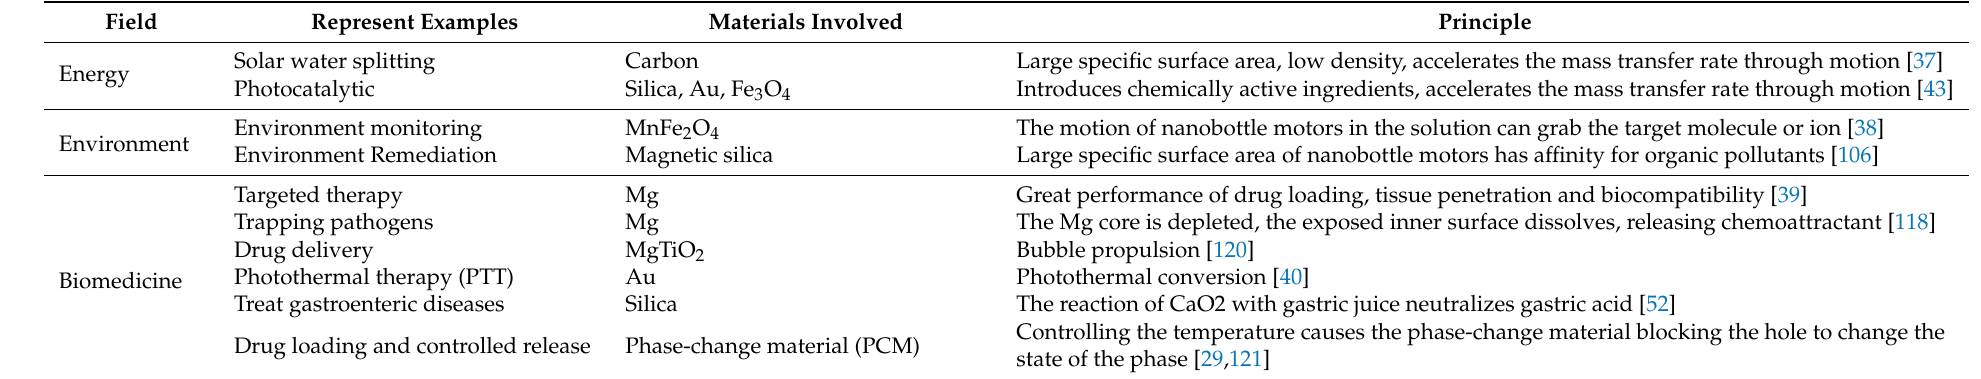
Table 2. Some typical applications of nanobottle motors.